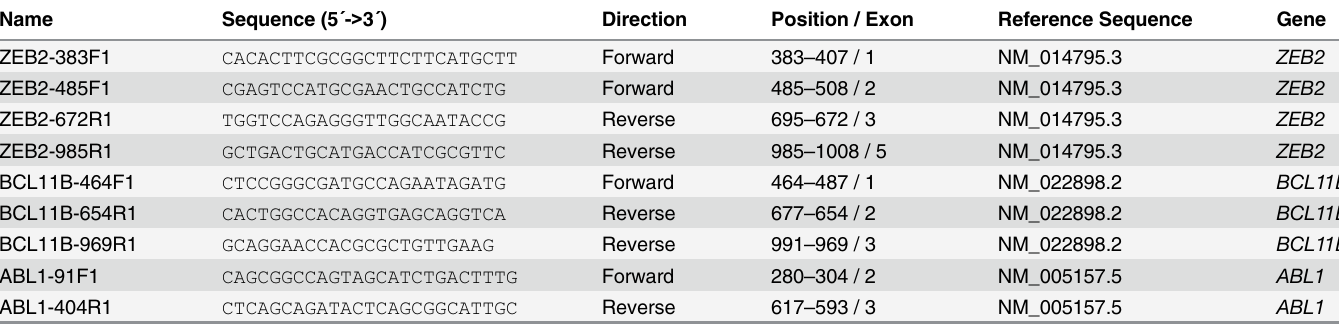
Table 2. Primers used for PCR amplification and Sanger sequencing